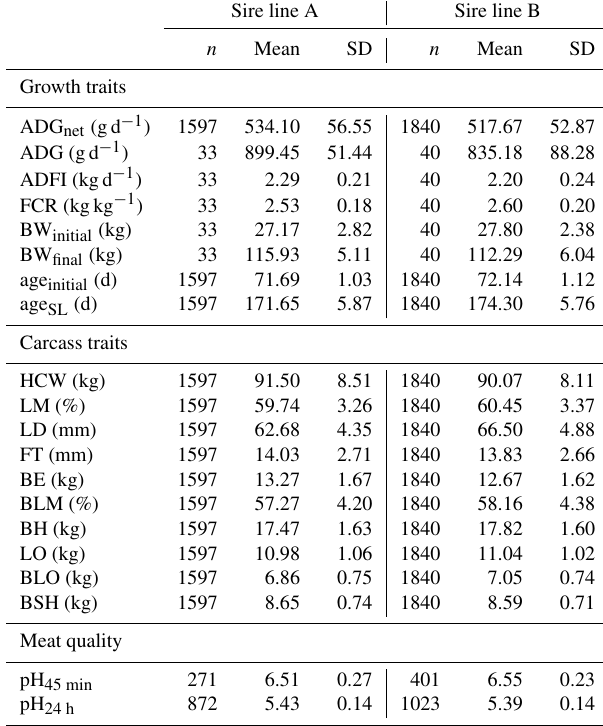
Table 3. Descriptive statistics with number of observations, mean Table 4. LSQ mean (with SE as index) for growth traits, carcass and standard deviation for growth traits, carcass traits, and meat traits and meat quality according to the sire line. quality according to the sire line. Sire line Sire line A Sire line B SD